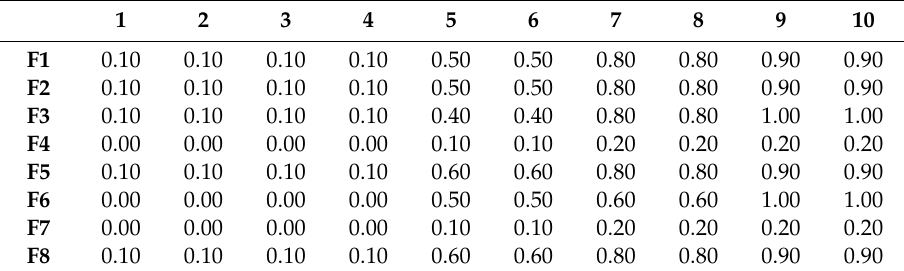
Table 11. Expert #3 favorable evidence degree versus VMEA weights.